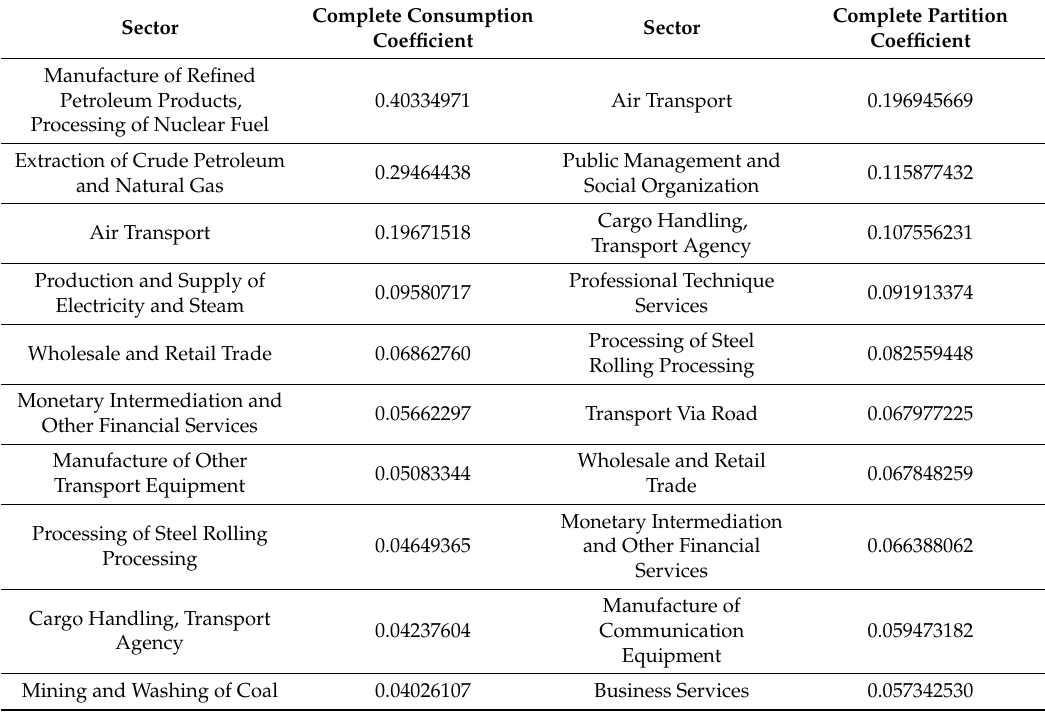
Table 4. Top 10 Complete consumption coefficients and the complete partition coefficient of 139 sectors of